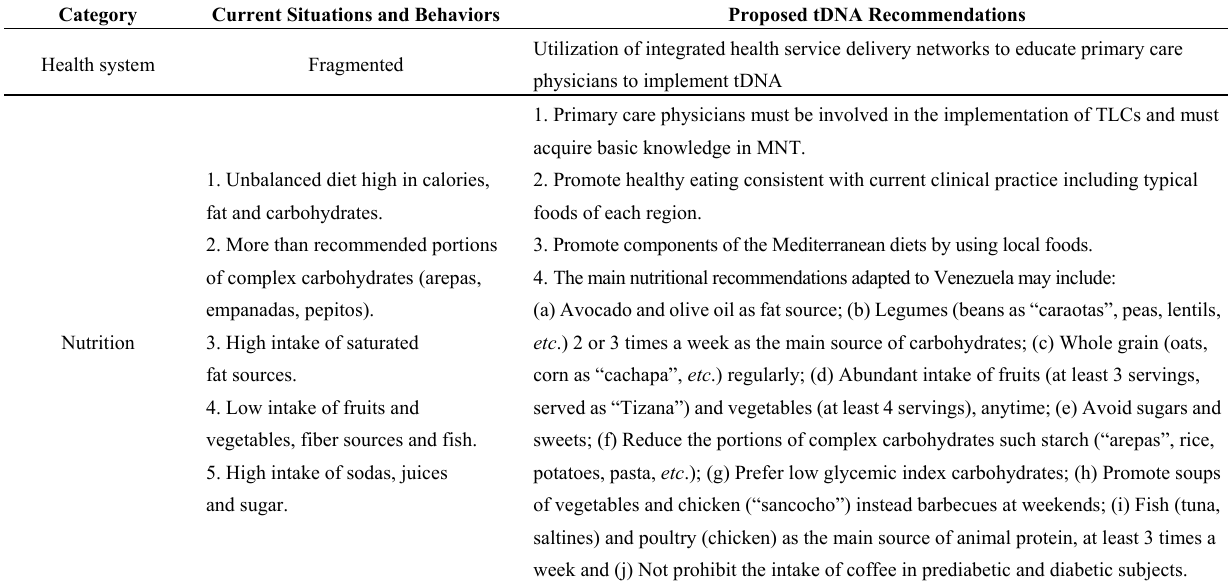
Table 9. Summary of current status and proposed tDNA recommendations for